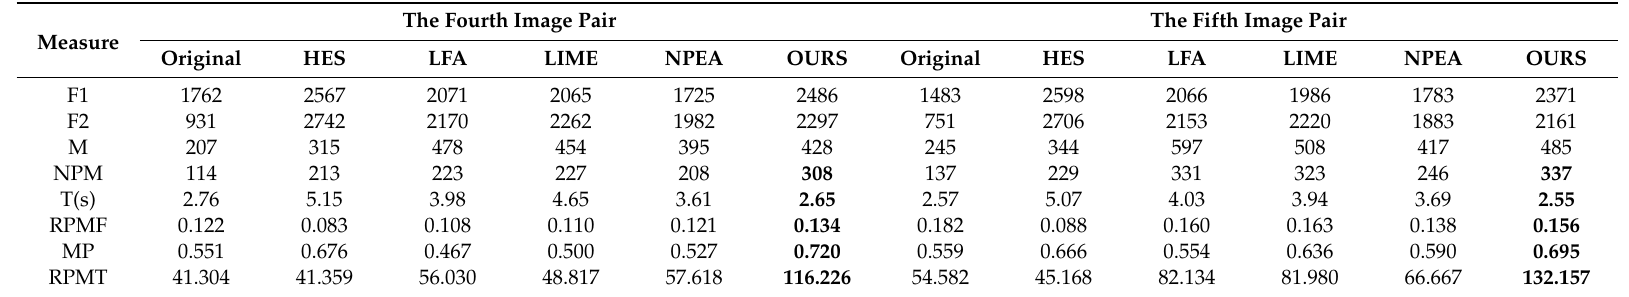
Table 5. Numerical performance indicators of SURF for the fourth and fifth image